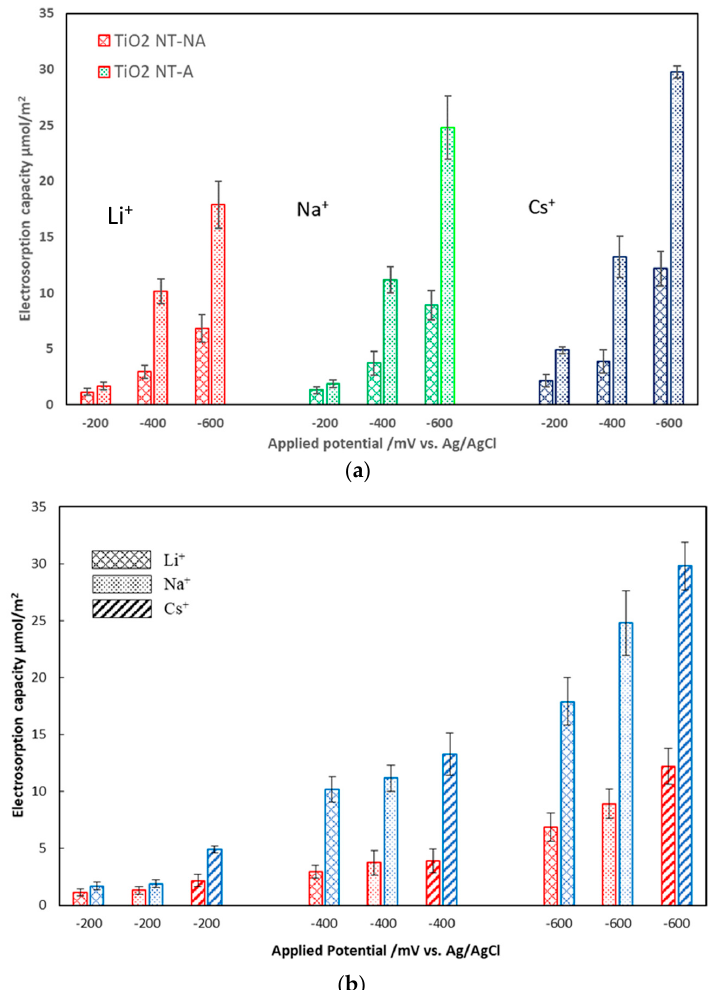
Figure 2. Electrosorption capacity of Li + , Na + , and Cs + ( a ) at various applied potentials; and ( b ) for different electrodes (red bars for TiO 2 NT-NA and blue bars for TiO 2 NT-A).